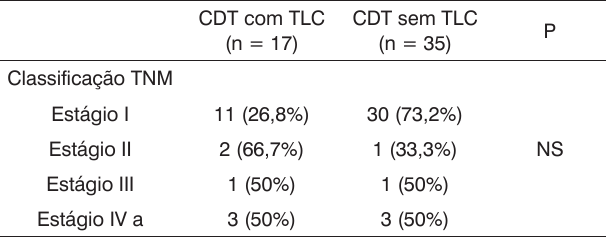
CDT: Carcinoma Diferenciado de Tireoide, TLC: Tireoidite Linfocitária Crônica, P = NS: estatisticamente não significativo, TNM: Classificação proposta pelo American Joint Committee on Cancer